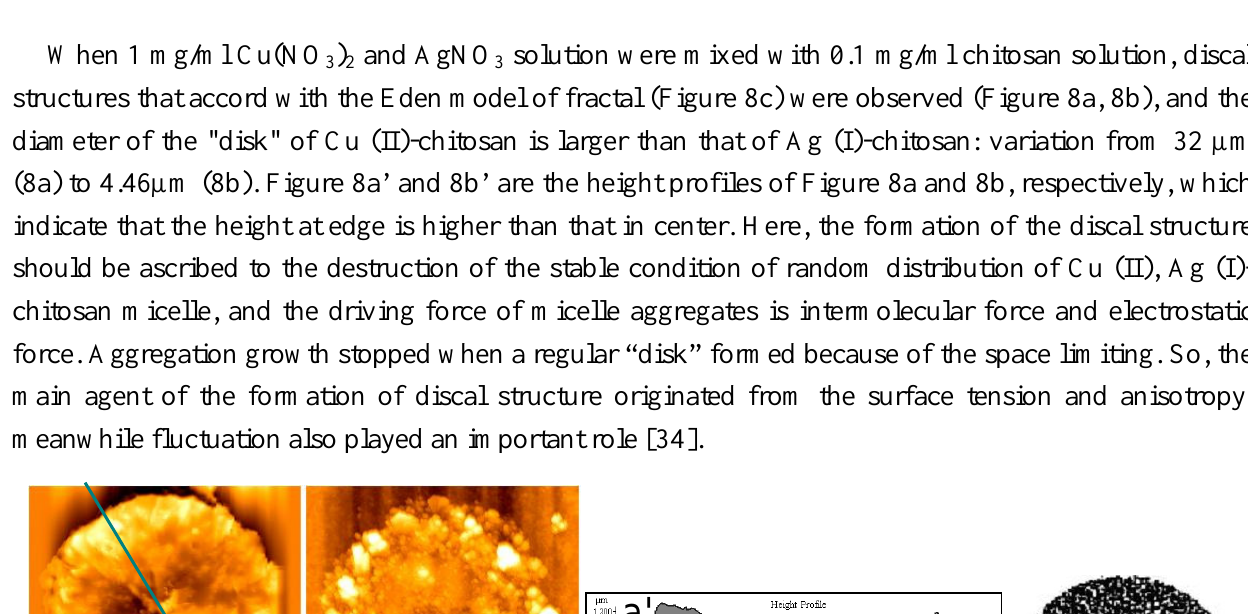
Figure 7. The self-assembly images of Cu (II)-chitosan micelle (a, b), the size of micelle in Figure 7a is 1.35µm~1. 85µm in diameter, 290nm~450nm in height, their mean values are 1.52µm and 373 nm, respectively. Figure c and d are fractal structural images of Cu (II), Ag (I)-chitosan aggregates, and the fractal dimensions are 1.947 (c) and 1.957 (d), respectively.